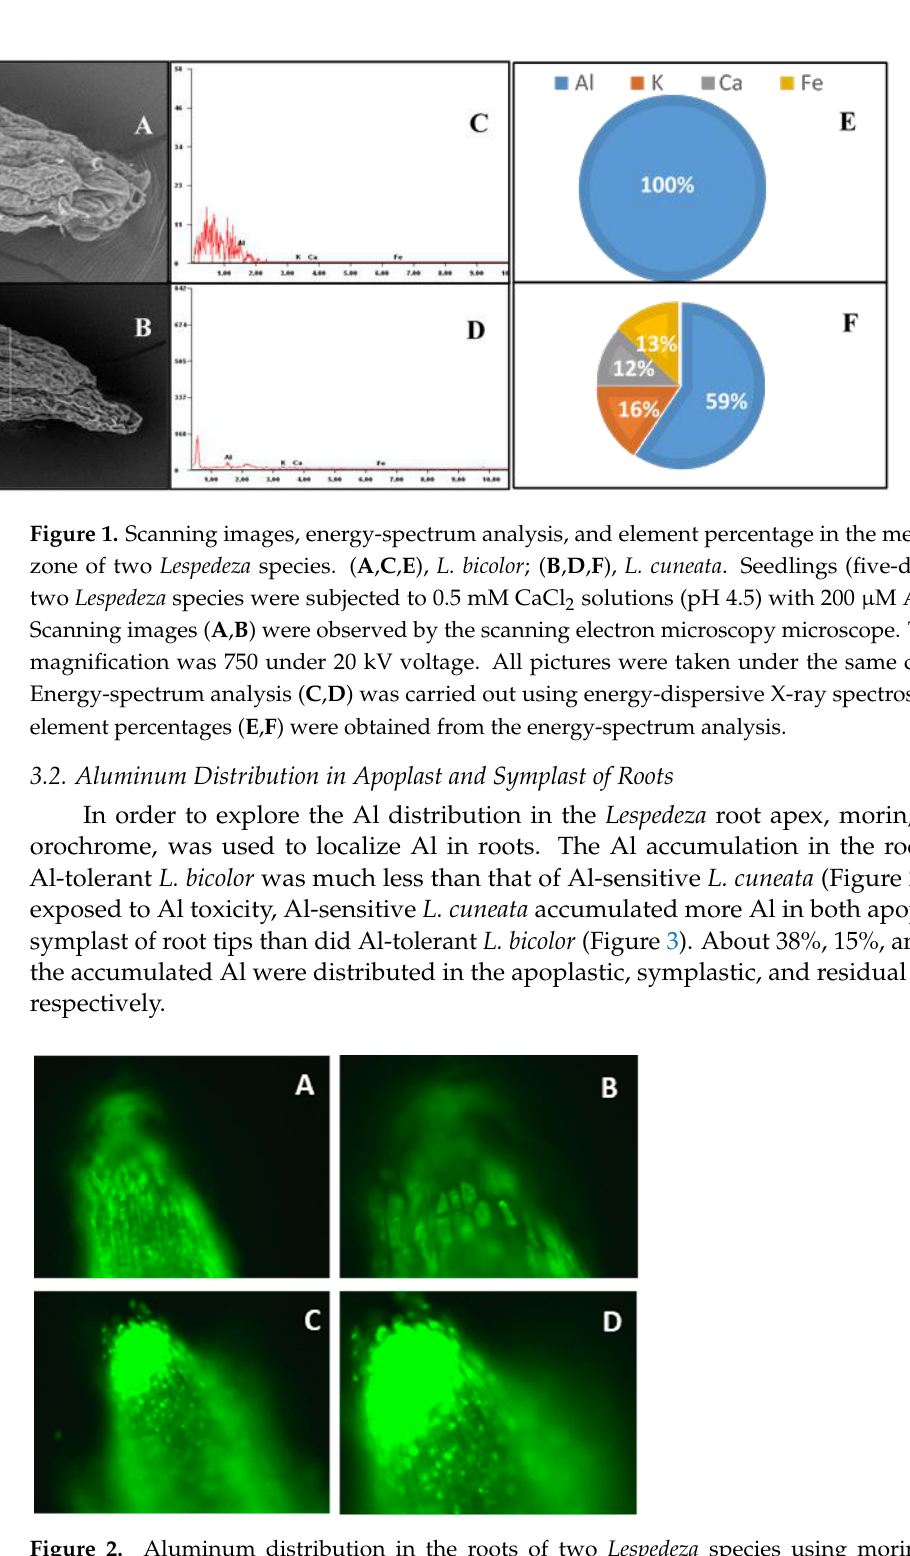
Figure 2. Aluminum distribution in the roots of two Lespedeza species using morin staining. ( A , B ),